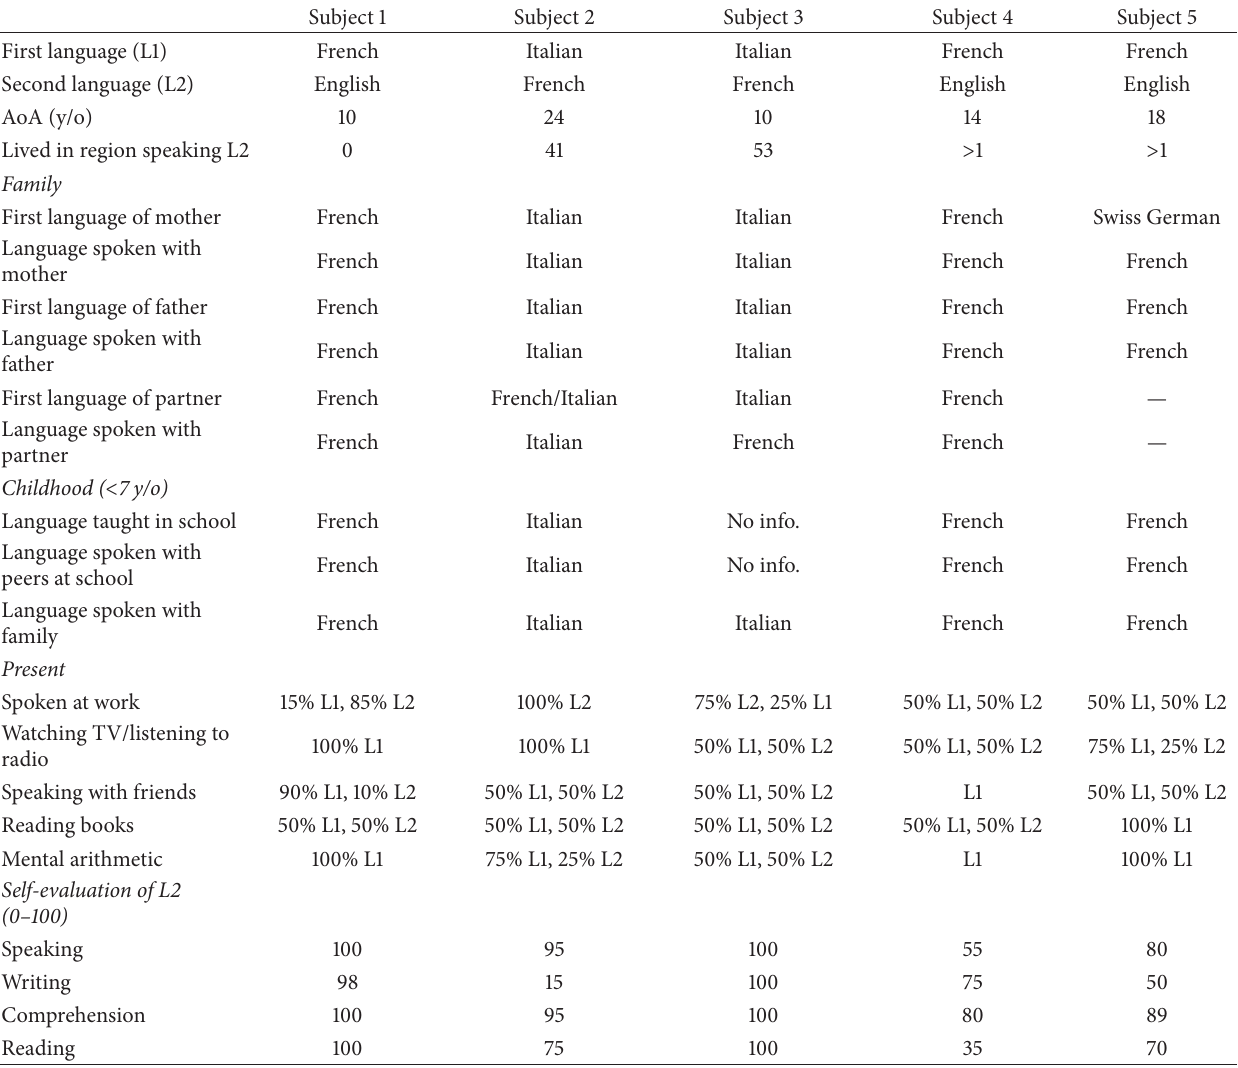
Table 1: Assessment of premorbid L2